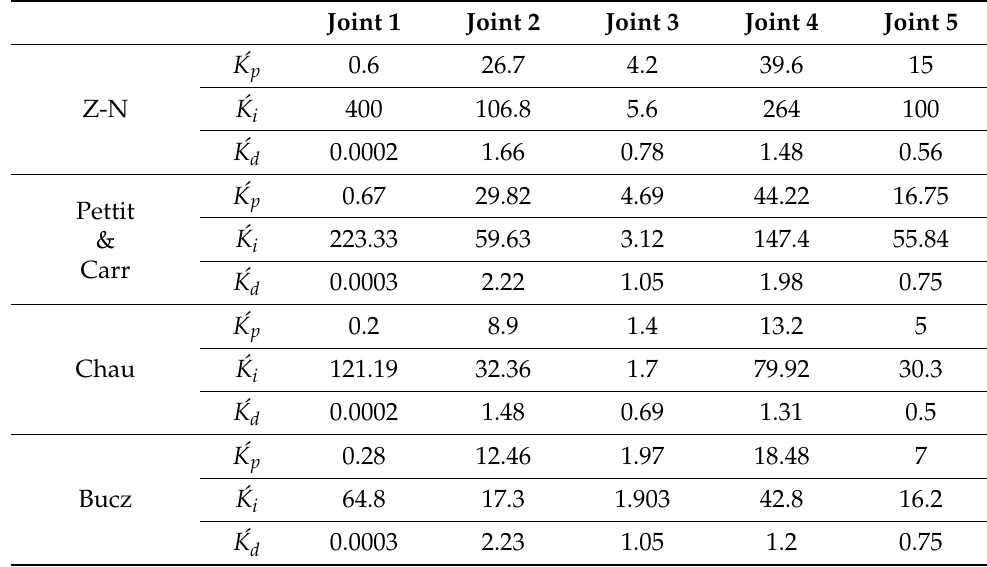
Table 3. PID parameters tuned by conventional observation